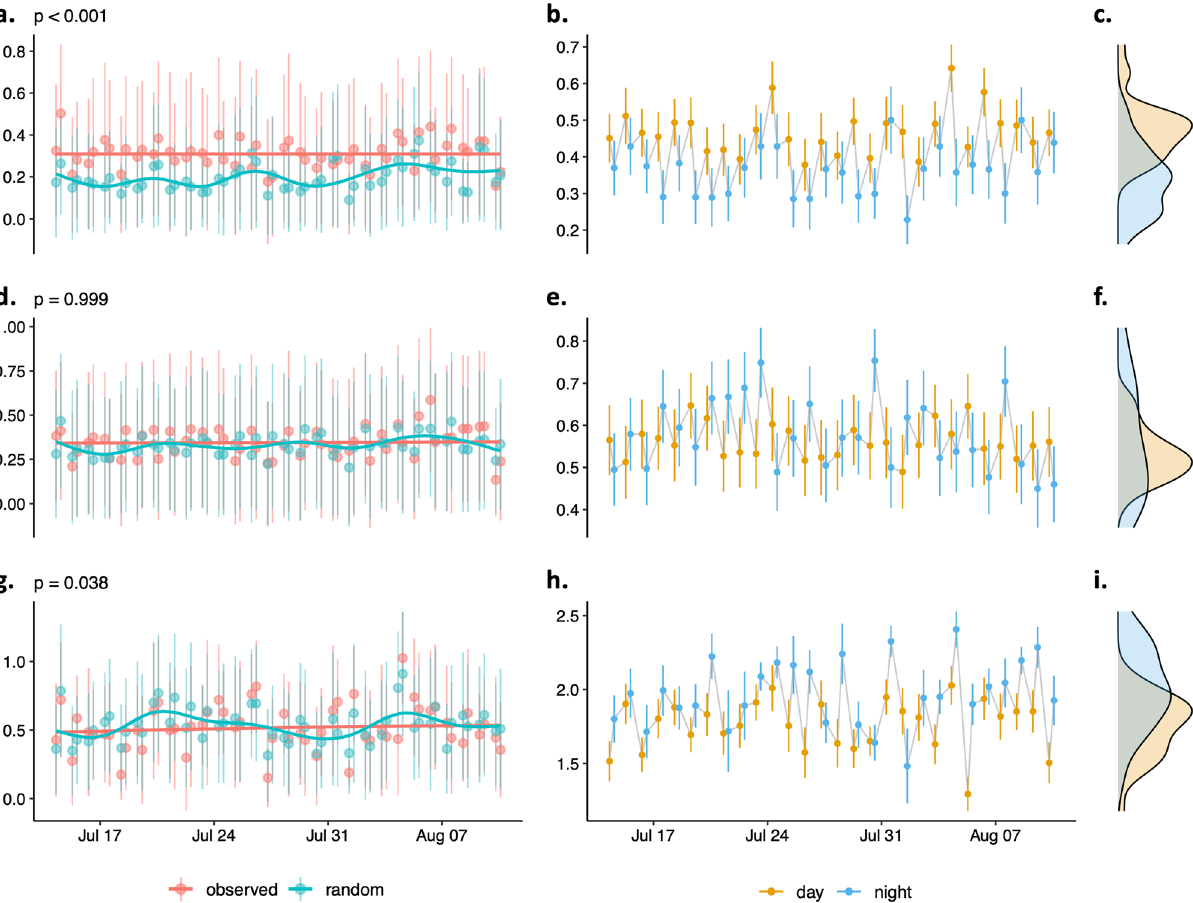
Fig. 3 Non-random patterns in variations of network traits between consecutive days and nights. Observed and random absolute daily differences in network traits between consecutive days and nights in ( a ) individual strength centrality, ( d ) individual eigenvector centrality, and ( g ) individual selectivity. Permutation-based p values determine whether the observed absolute differences between consecutive daytime and nighttime network traits were larger than random differences predicted under the null hypothesis. Average network trait per day and per night and cumulative distributions of daytime and nighttime average network traits in ( b , c ) individual strength centrality, ( e , f ) individual eigenvector centrality, and ( h , i ) individual selectivity. Data points represent daily averages and error bars represent the standard deviation around the